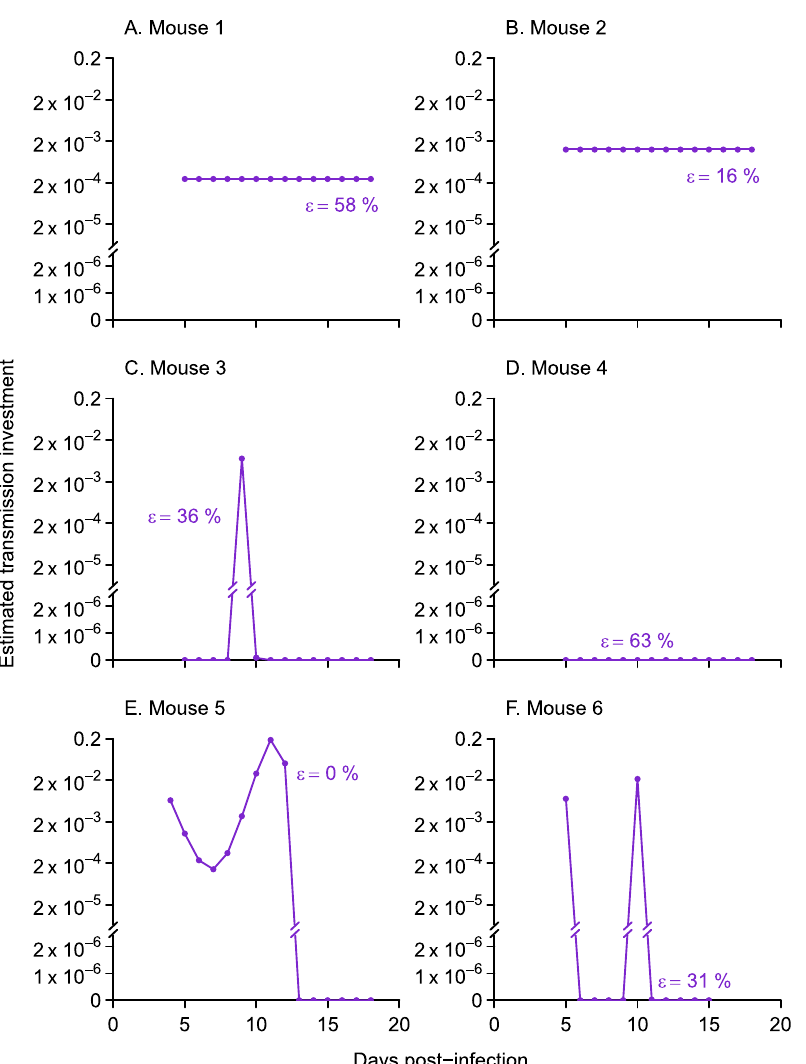
the best fit to logged gametocyte counts (S5 Fig). When the proportion gametocyte carryover ( (cid:2) ) was allowed to vary between zero and one (purple closed dots), three mice showed constant levels of transmission